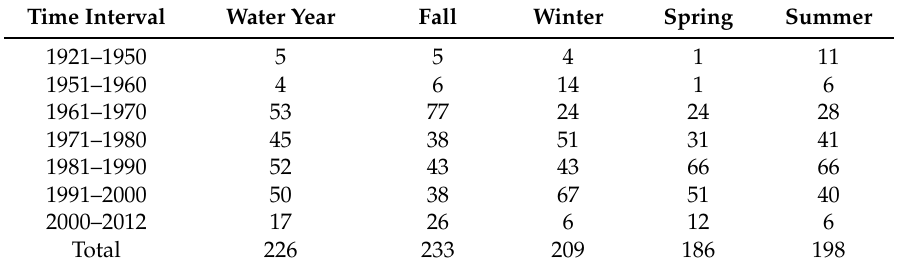
Table 3. Number of stations showing shifts at different time intervals in water year and the four seasons. Time Interval Water Year Fall Winter